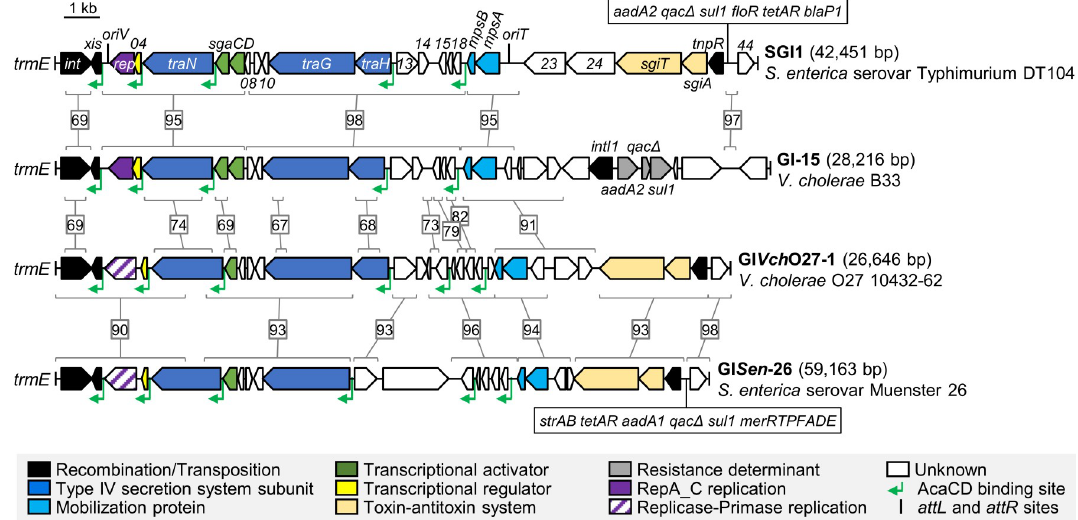
Fig 6. Comparison of the genetic maps of 4 SGI1-like genomic islands. Genomic islands are drawn to scale. The left and right junctions ( attL and attR ) within the host chromosome are indicated by black bars at the ends. ORFs with similar function are color coded as indicated in the figure. Green flags indicate the position and orientation of AcaCD binding sites predicted using MAST of the MEME suite [30]. Homologous regions are bracketed and linked by a gray line with the corresponding percentage of nucleotide identity. Genbank accession numbers: SGI1, AF261825.2; GI-15, AAWE01000022); GI Vch O27-1, CP010812; GI Sen -26,